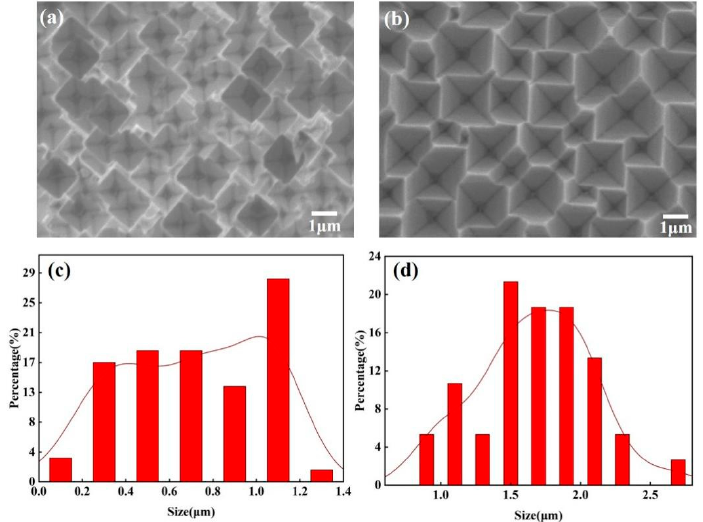
Figure 10. SEM image and results of sample structure size: ( a , c ) NSR technology processed inverted pyramid structure; ( b , d ) Ag@PVP–ACE one-step textured inverted pyramid structure.